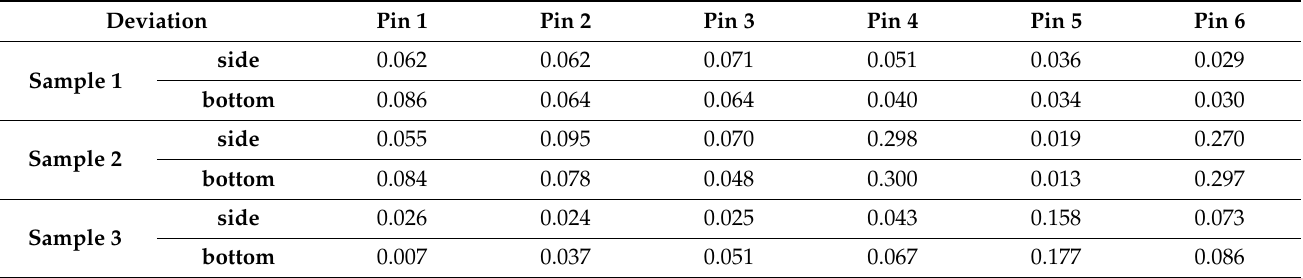
Table 2. The deviations of the first six pins of the three samples measured in case study two. “Side” means that the measurement was performed from the side of the samples using the proposed method, and “bottom” means that the measurement was performed from the bottom of the samples using the 2D